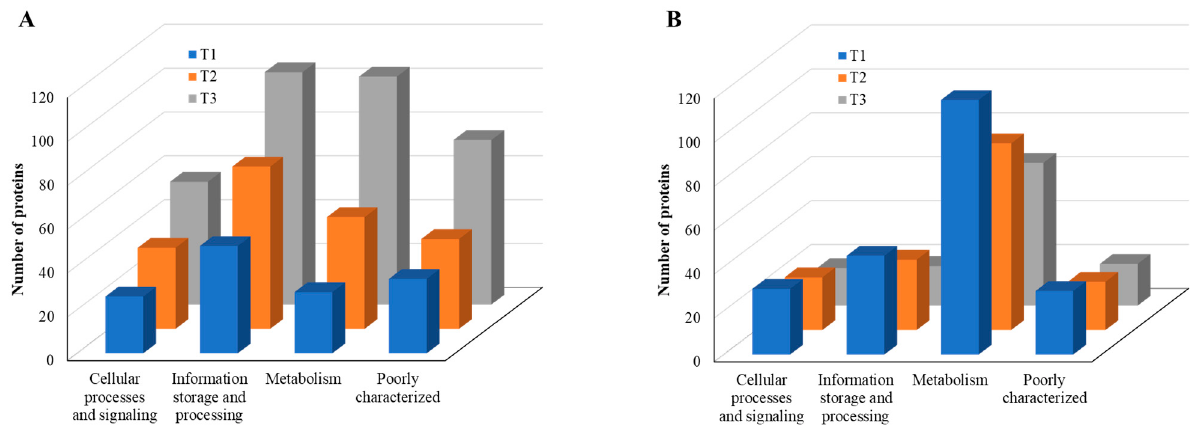
Figure 7. The number of differentially expressed proteins identified from S. epidermidis strain RP62A